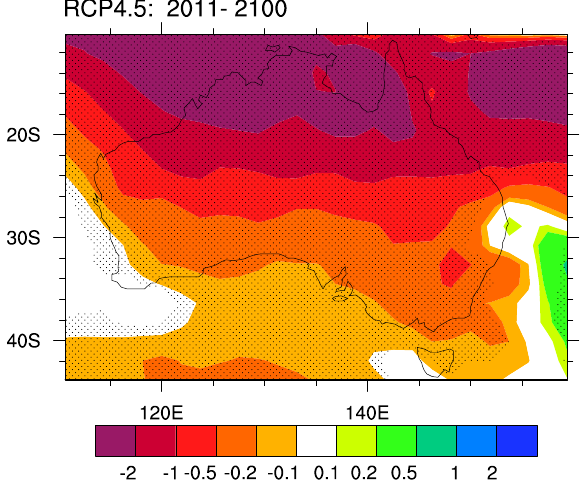
Fig. 12. Simulated DJFM rainfall trends (mmday − 1 century − 1 ) from RCP4.5 (2011–2100). Stippled trends are significant at